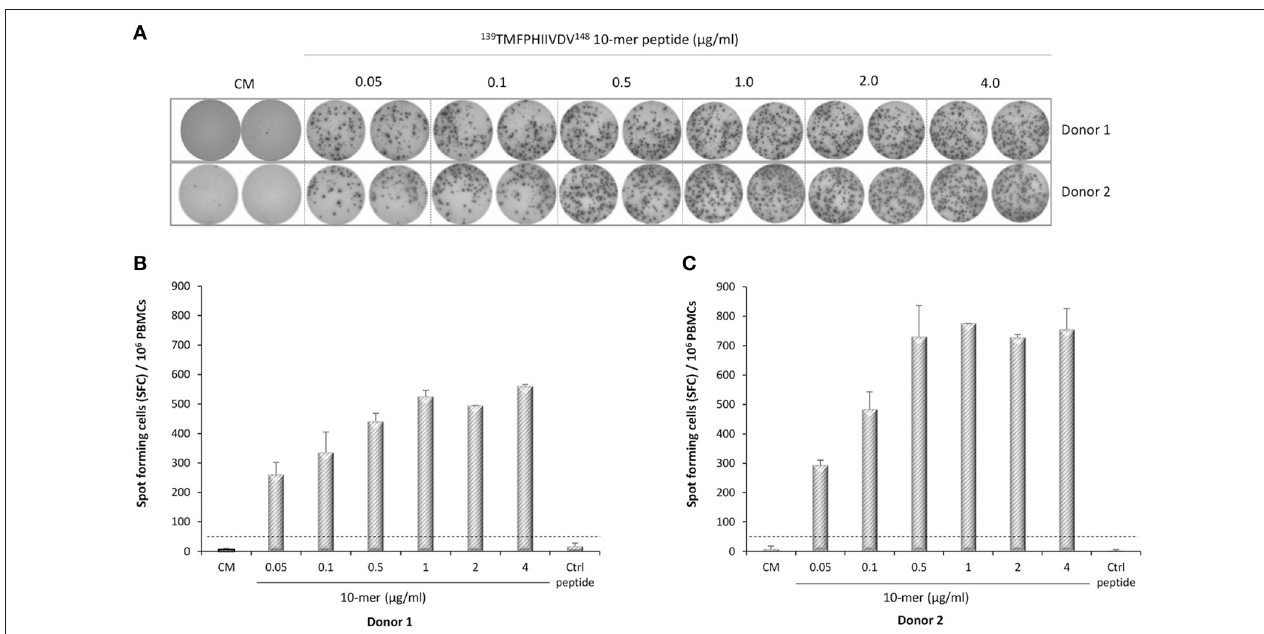
FIGURE 3 | Norovirus epitope 139 TMFPHIIVDV 148 –specific enzyme-linked immunosorbent spot (ELISPOT) interferon-gamma (IFN- γ ) responses. PBMCs of Donor 1 (A,B) and Donor 2 (A,C) positive for HLA-A * 0201 allele were stimulated with an increasing concentration (0–4 µ g/ml) of the 10-mer epitope peptide, 4 µ g/ml irrelevant 9-mer peptide (Ctrl), or left unstimulated (CM, culture media). Images of the ELISPOT replicate wells with the stained spot-forming cells (SFC) are shown (A) . Mean SFC/10 6 PBMCs of two replicate wells with the standard errors of the mean for Donor 1 (B) and Donor 2 (C) . The cut-off line (dotted line) indicates the positive SFC/10 6 value of ≥ 50 SFC/10 6 cells and twice above the background control (CM only